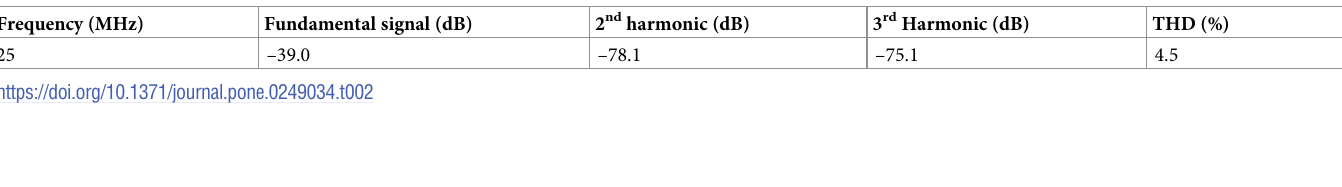
Table 2. Ultrasonic echo signal